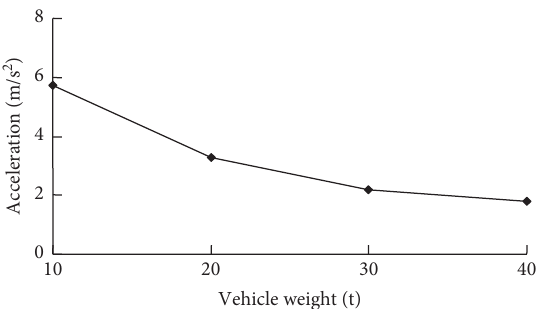
Figure 25: The variation curve of peak values of vertical vibration accelerations of the vehicle body.